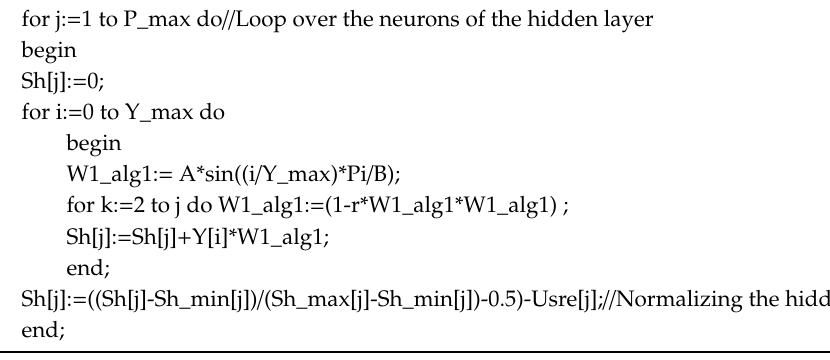
Algorithm A6.1. Algorithm 1.